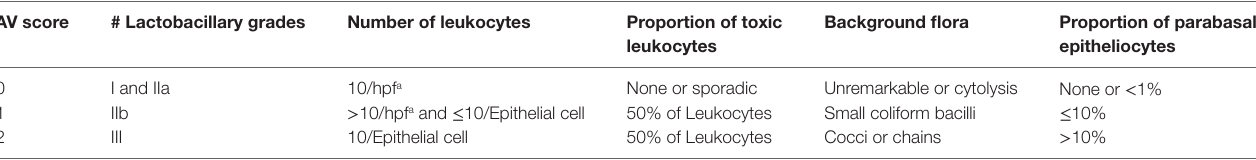
TABLe 2 | Microscopic diagnosis criteria for aerobic vaginitis (AV)